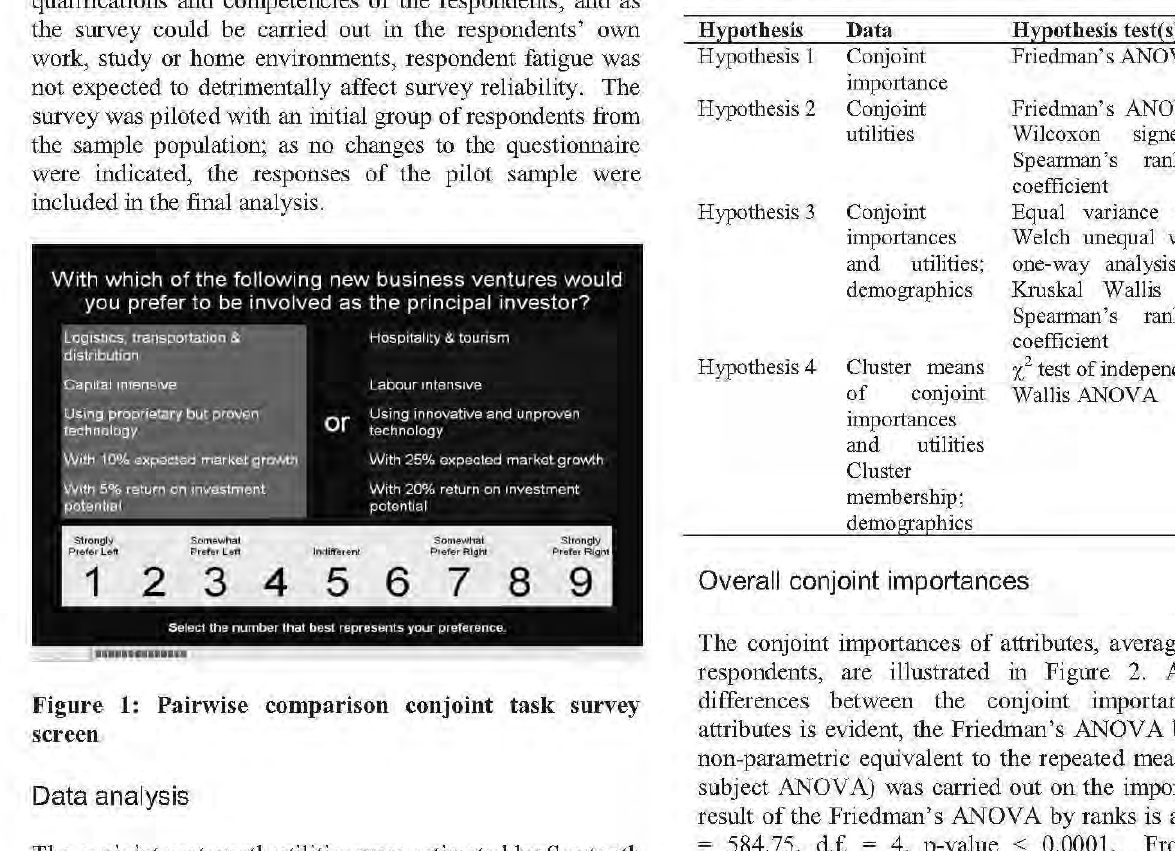
Table 2: Hypothesis tests for analysing conjoint